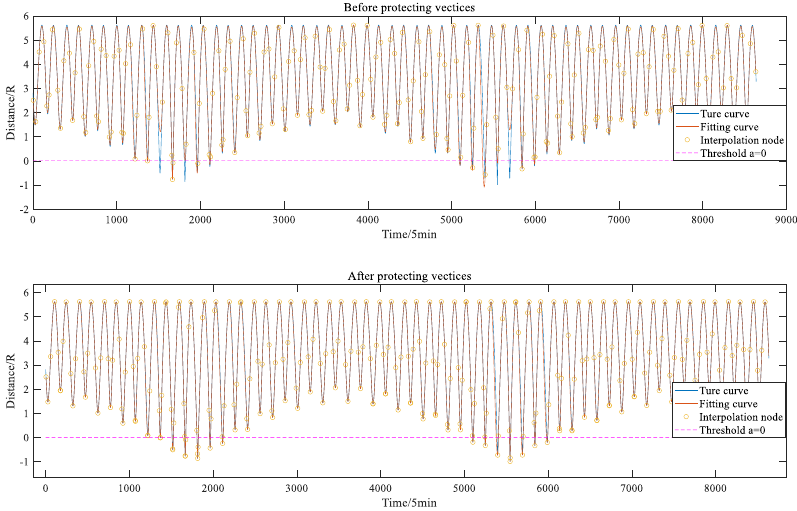
Figure 6. Effects of vertex protection algorithms on fitting of Earth occultation functions.